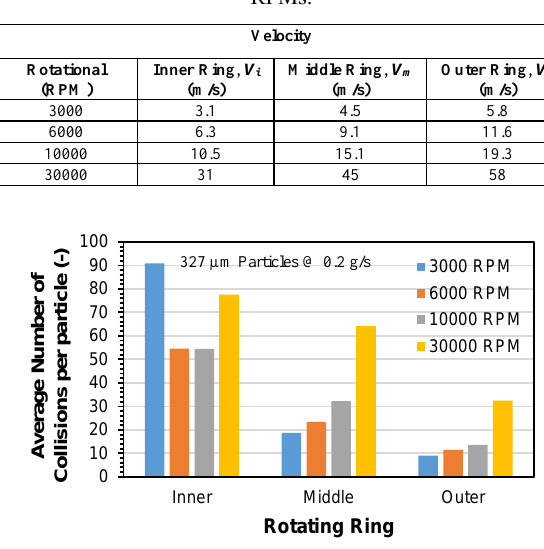
Table 2. Linear velocity of the three rotating ring at different RPMs.